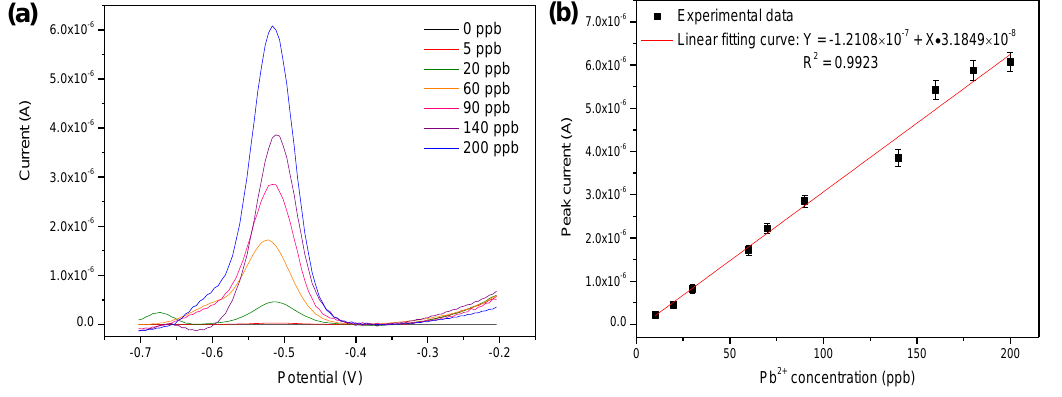
Figure 8. ( a ) SWV of rGO-SPCE in NaOH/HAc solution containing various concentrations of Pb 2+ ; ( b ) The calibration curve of the linear dependence of cathodic peak current on Pb 2+ concentrations. The data for respective error bar were calculated from four separate experiments.